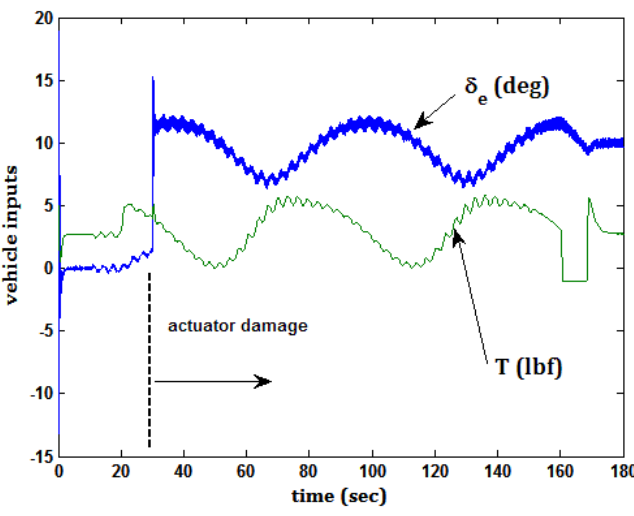
Figure 8. Elevator and thrust inputs for Task 1.